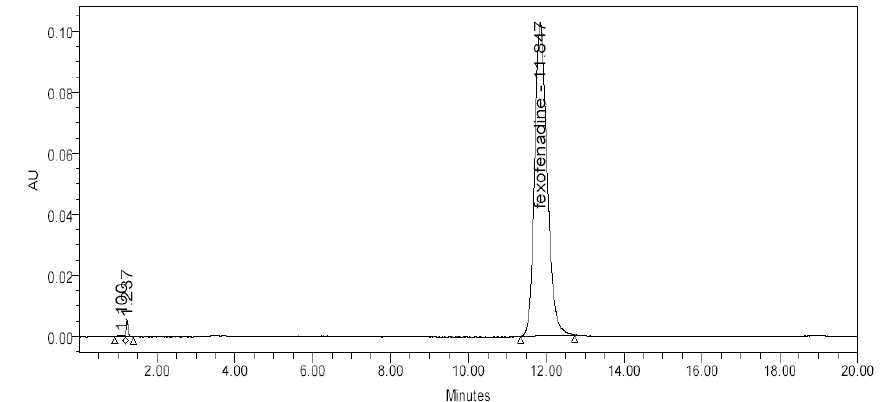
Figure 2. Chromatogram of standard drug. The mobile phase phosphate buffer: acetonitrile: methanol (60:20:20; v/v/v) with pH 3.7 adjusted with o-phosphoric acid. Peak of standard drug retention time T =12.1 ±0.9 min, 210 nm. R